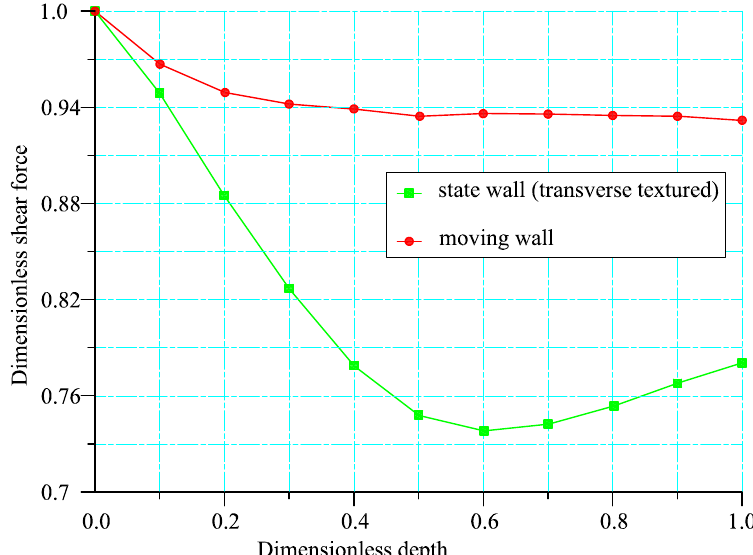
Figure 10. Influence of dimensionless depth of microtexture on wall shear force in transverse texture model.